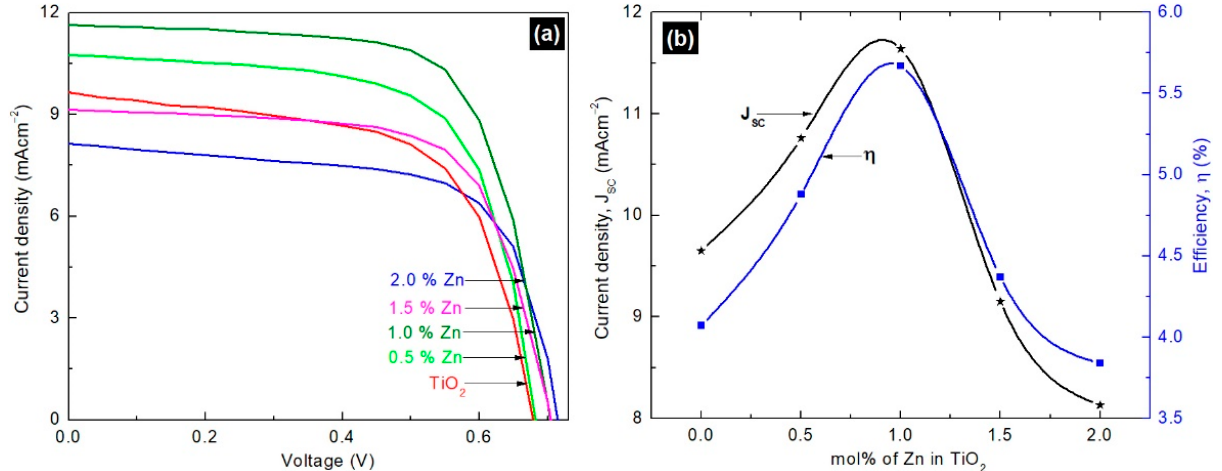
Figure 4. ( a ) Photovoltaic performances of Dye Sensitized Solar Cells (DSSCs) with undoped and Zn-doped TiO 2 photoanodes; ( b ) variations in short circuit current density (Jsc) and efficiency ( η ) with different mol% Zn dopants under illumination of intensity 100 mWcm − 2 with Air Mass (AM) 1.5 filter. Table 2. Photovoltaic parameters of DSSCs with undoped and Zn-doped TiO 2 photoanodes under illumination of intensity 100 mWcm − 2 with AM 1.5 filter.